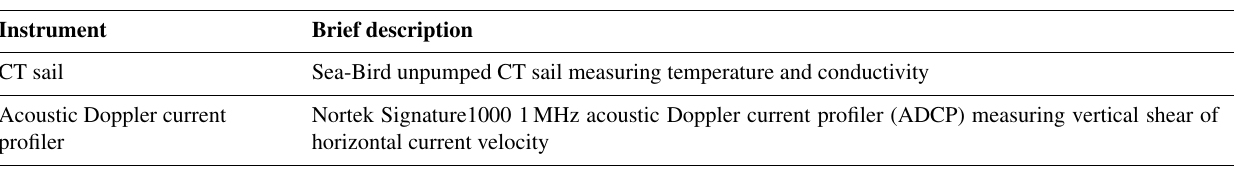
Table B18. Omura (SG637).